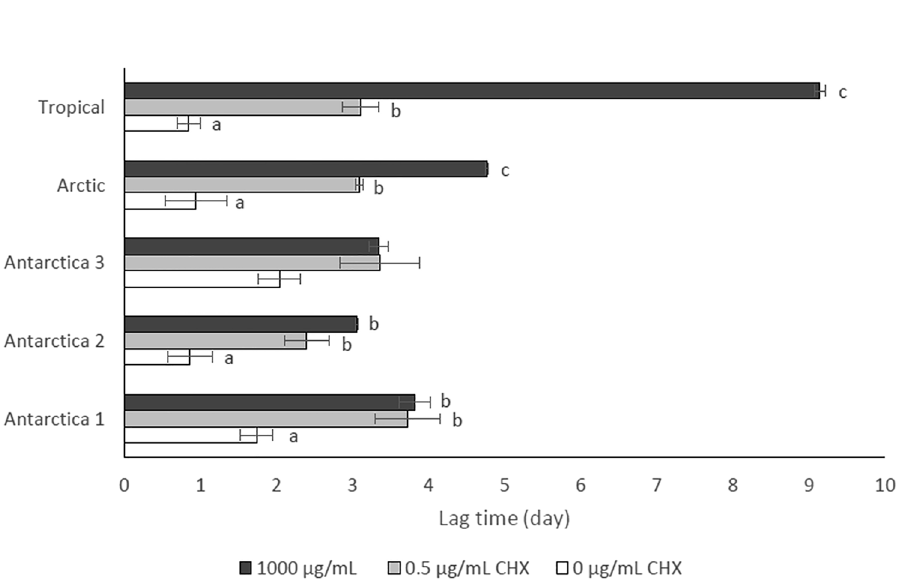
Figure 3. Mean (± standard error) of the lag time for each of five strains of Stichococcus -like algae to reach constant growth rate in control BBM, BBM + 0.5 µg/mL CHX and BBM + 1000 µg/mL CHX. Means with different letters (a, b, c) are significantly different (Tukey’s HSD, p <